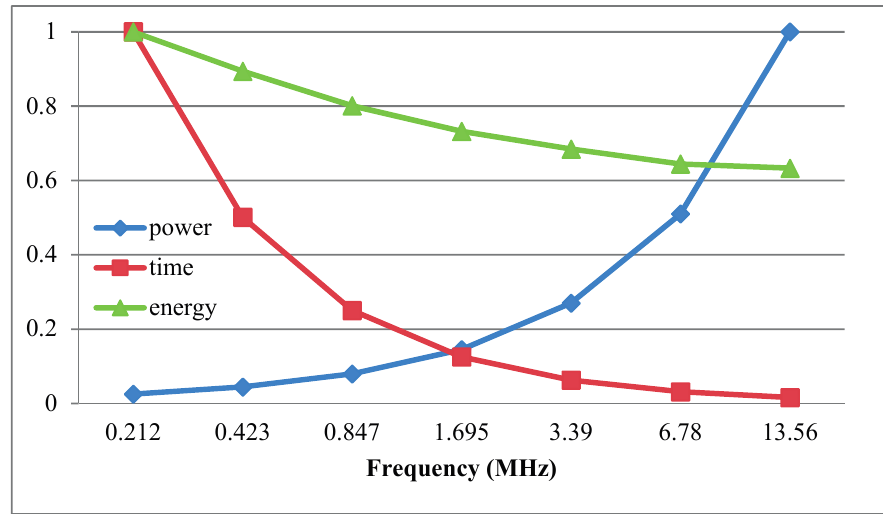
Figure 11. Normalized time, power and energy for one scalar point multiplication under different work